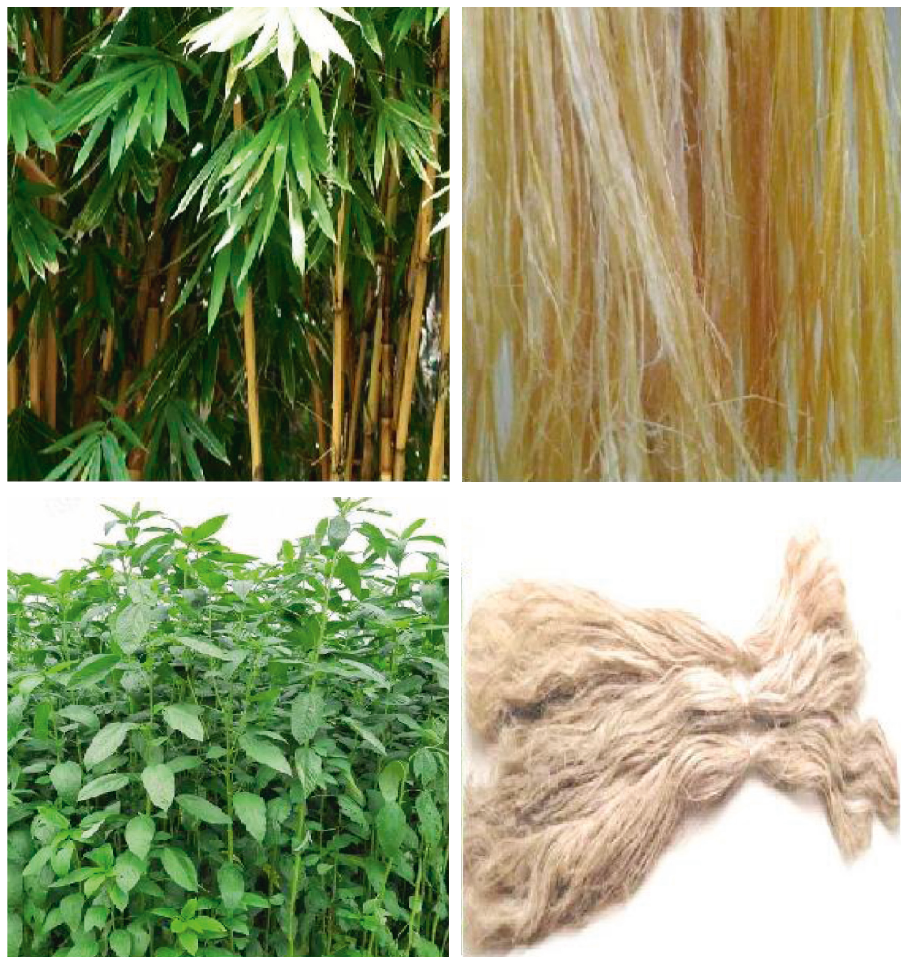
Figure 1: Fibers extracted from plants and their